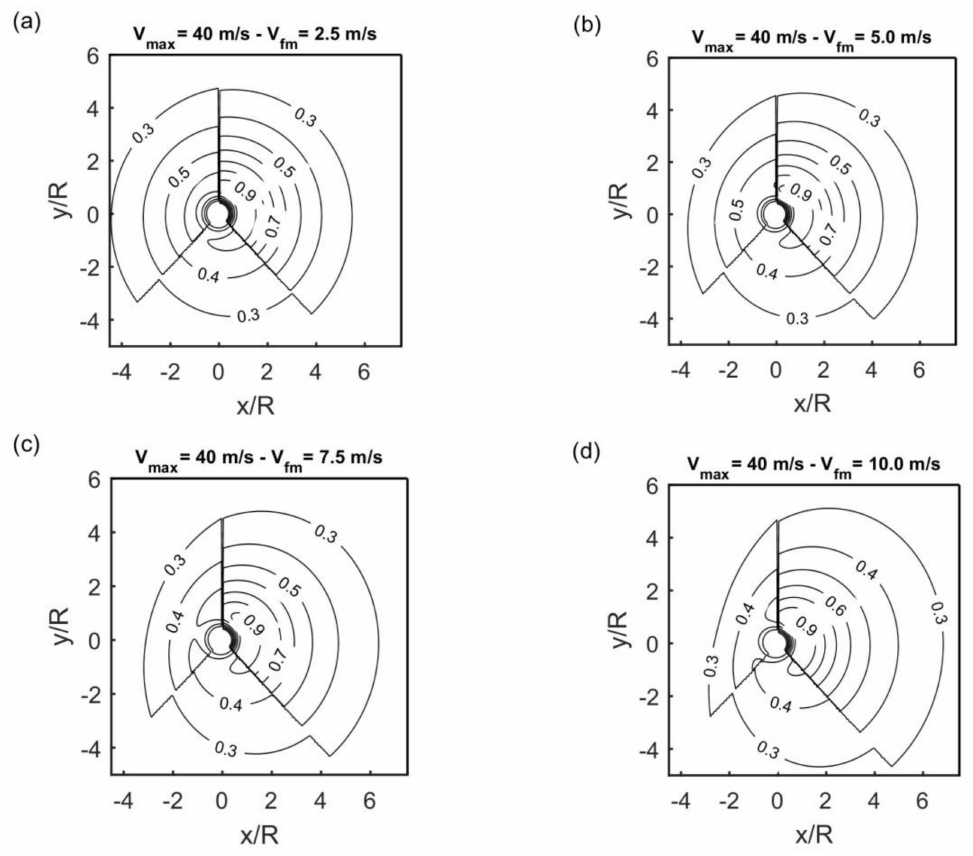
Figure 6. Tropical cyclone wave fields, calculated from the model of Hwang [48] and Hwang and Walsh [49]. Contours are of H s / H max s . Each of the panels ( a ) to ( d ) is for a different combination of V fm and V max , as